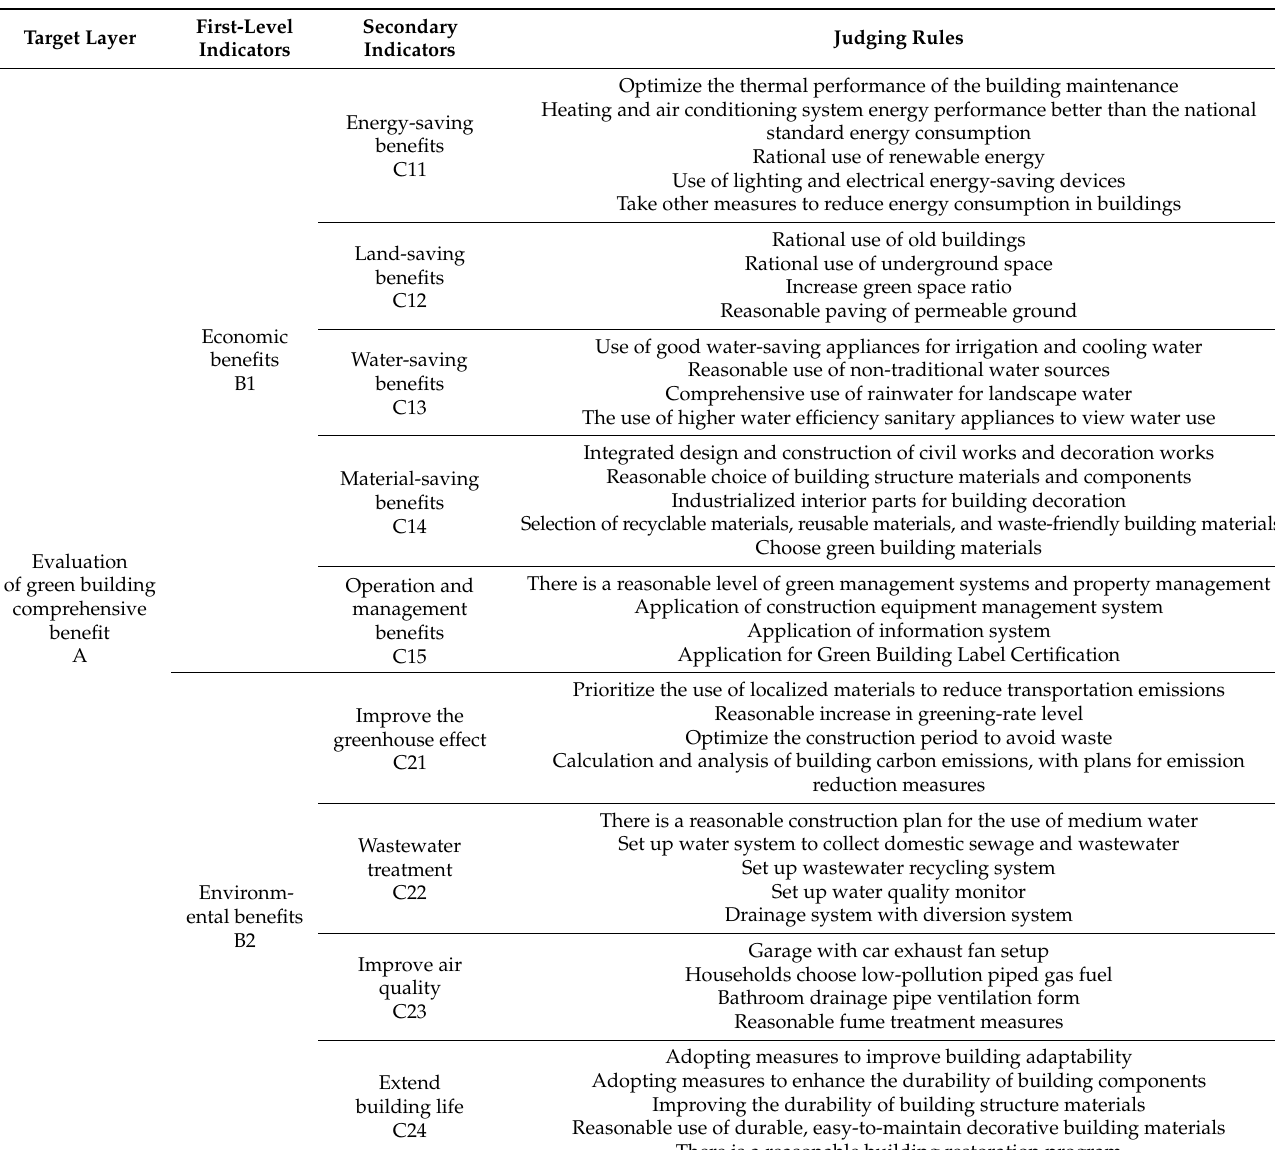
Table 1. Comprehensive benefits of green buildings evaluation